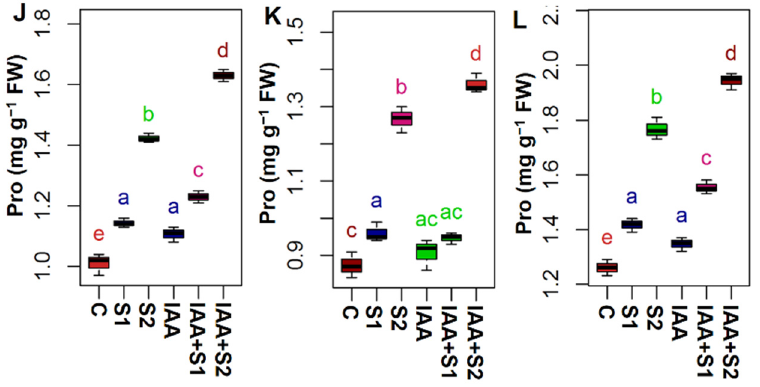
Figure 2. Effects of exogenous IAA on various osmolytes and primary metabolites in the roots, stem and seeds, including ( A – C ) total soluble sugars (TSS), ( D – F ) total soluble proteins (TSP), ( G – I ) total free amino acid (TFAA), and ( J – L ) proline (Pro) content of V. faba plants grown under non-stress and saline conditions. Each boxplot represents values of three independent replicates ( n = 3). Different letters above the bars indicate a statistically significant difference ( p < 0.05) by Tukey’s test. C, (control) 0 mM NaCl + water spray; S1, 60 mM NaCl + water spray; S2, 150 mM NaCl + water spray; IAA, 0 mM NaCl + 200 ppm IAA; IAA + S1, 60 mM NaCl + 200 ppm IAA; IAA + S2, 150 mM NaCl + 200 ppm IAA.